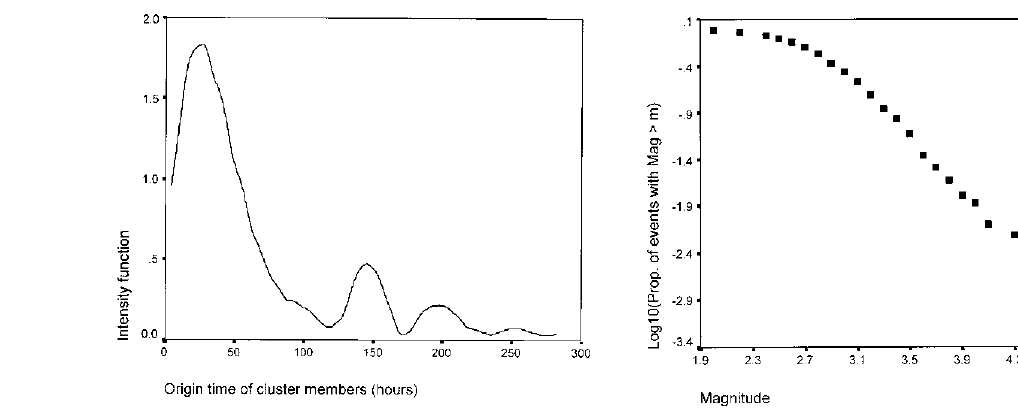
Fig. 12. Intensity estimation of the largest cluster.